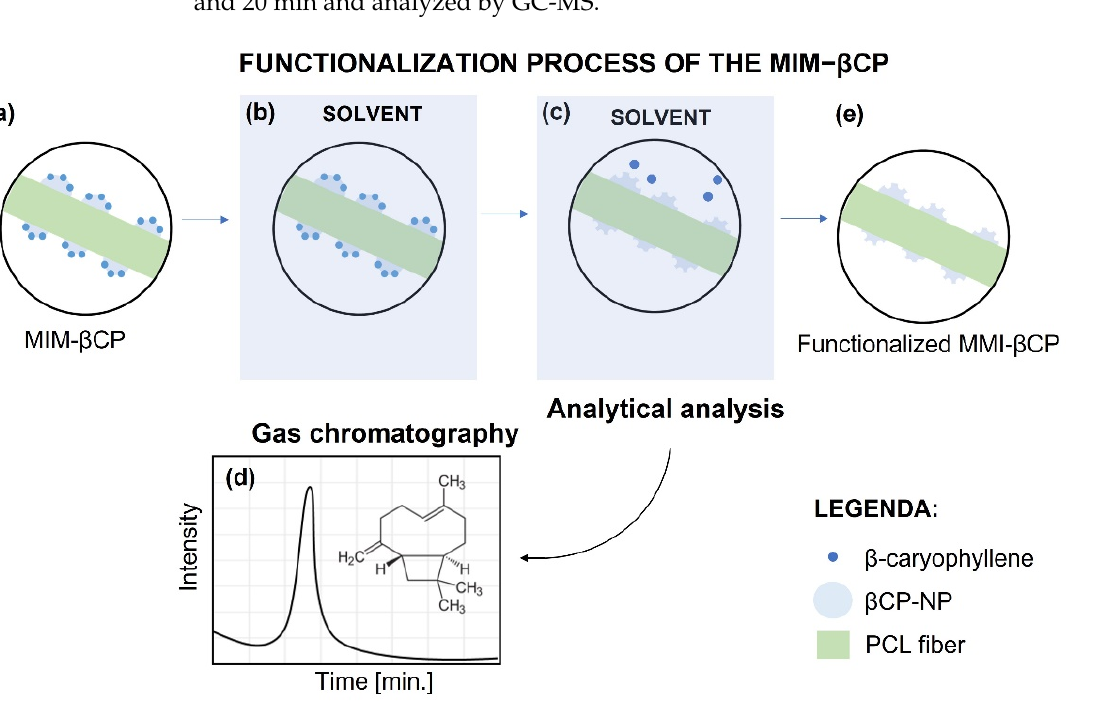
Figure 1. Experimental scheme of the functionalization process of MIM– β CP. ( a ) Electrospun MIM– β CP. ( b ) Electrospun MIM– β CP immersed into the solvent. ( c ) Removal of β CP from MIM– β CP. ( d ) Chromatogram of the β CP removed by wash. ( e ) Functionalized MIM– β CP.